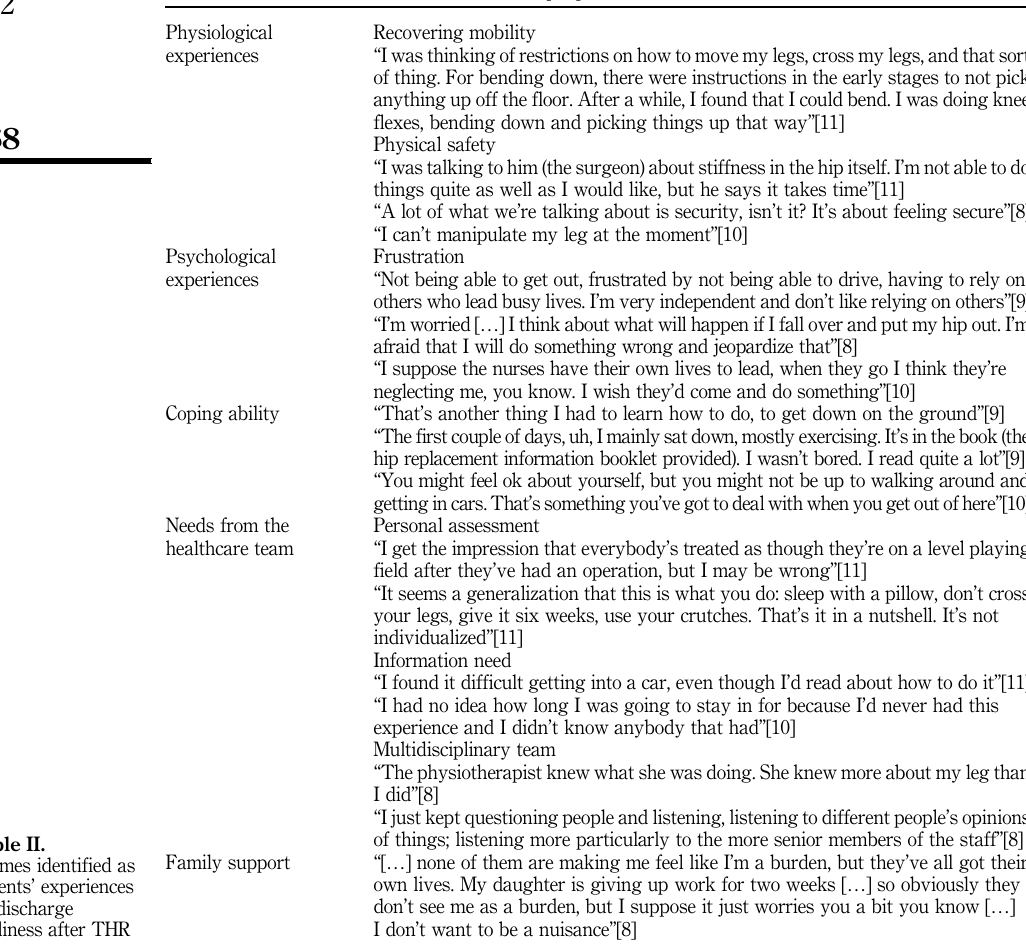
patients ’ experiences for discharge readiness after